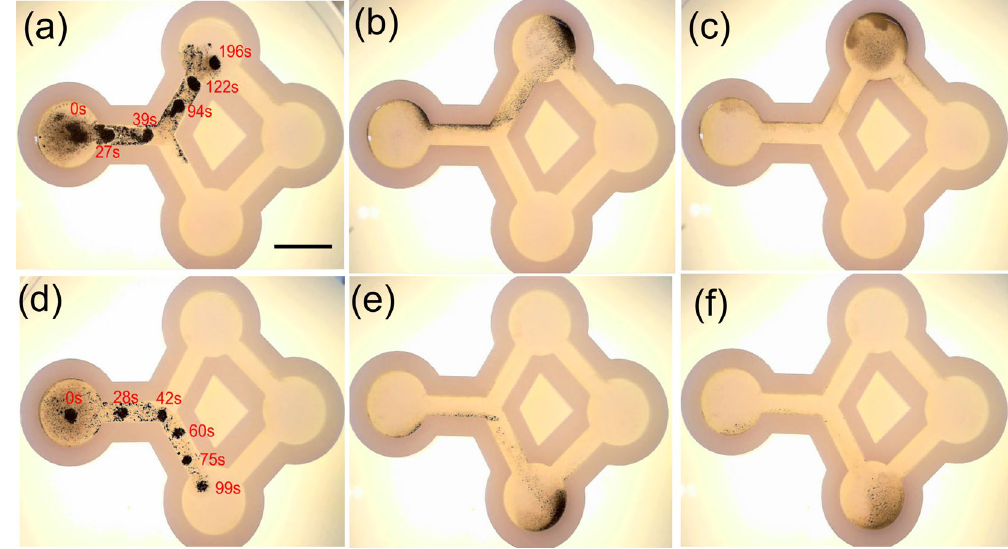
Figure 6. Time-lapse image of targeting tests in channel using vortex-like swarm toward top ( a ) and bottom ( d ) target sites. The red numbers at each point indicate the time when vortex is located; ( b , e ) enhanced tumbling motion toward top and bottom target sites, respectively. ( c , f ) Disaggregation of pattern after targeting top and bottom of channel. Scale bar: 10